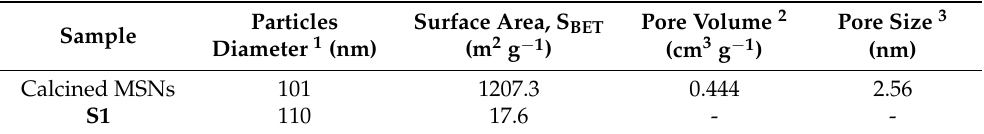
Table 1. Main structural parameters of calcined MSNs and S1 nanoparticles determined by TEM, PXRD and N 2 adsorption–desorption measurements.